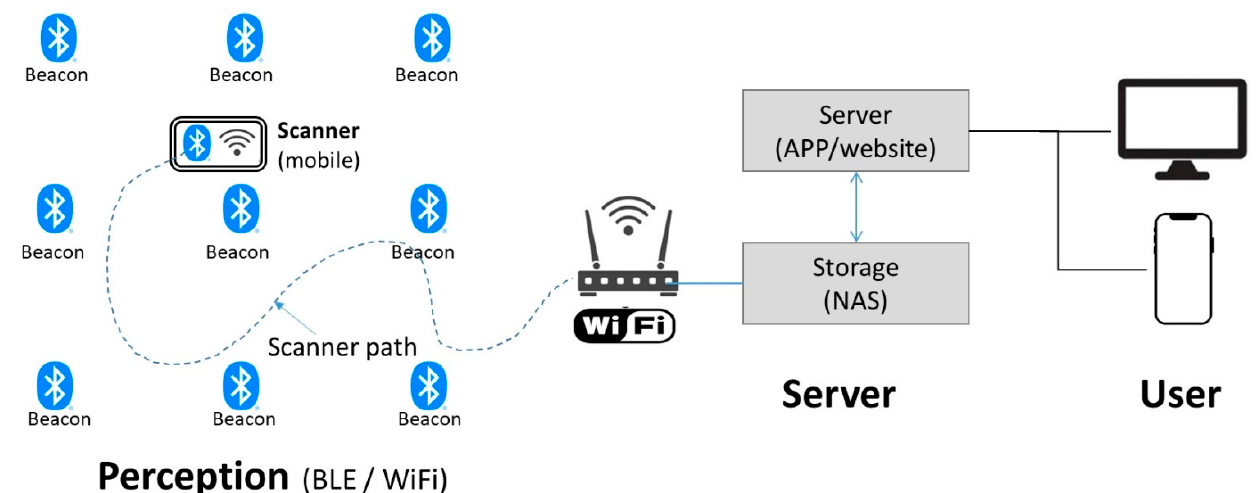
Figure 1. System Figure 1. System schematic.